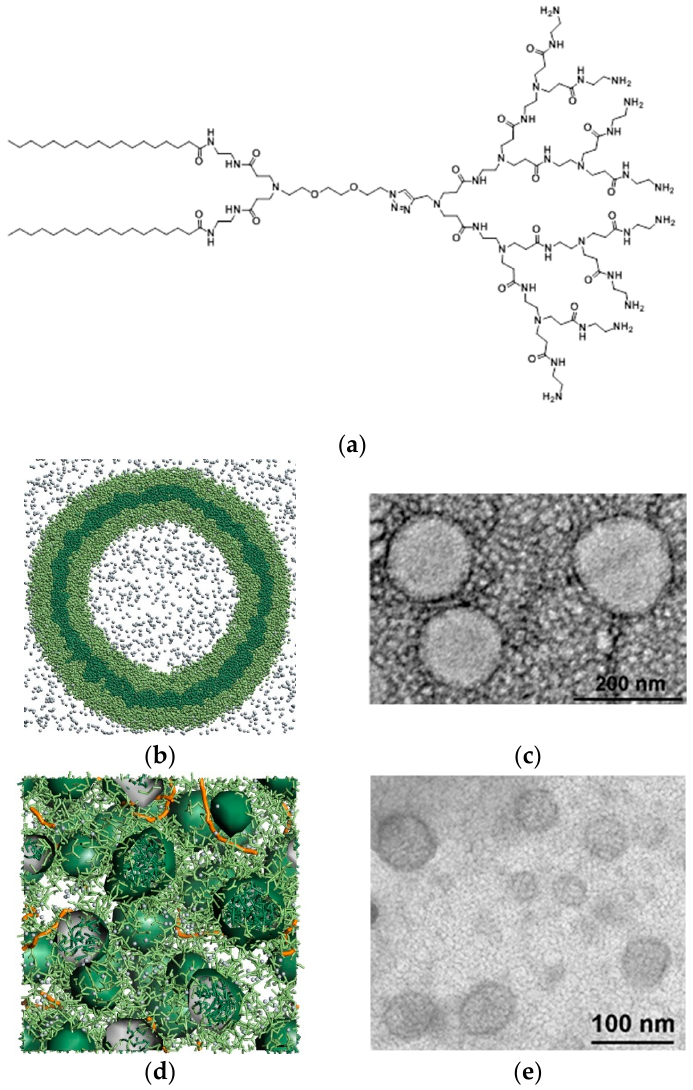
Figure 9. ( a ) The structure of the double-tail amphiphilic dendron simulated ( b ) and experimental TEM images ( c ) of the vesicle-like dendrimersomes formed by AD alone upon self-assembling in buffer solution. In panel b, the hydrophilic units of AD are portrayed in light green, the hydrophobic units are depicted in dark green, while light grey spheres are used to show some representative water molecules. Simulated ( d ) and experimental TEM images ( e ) of the nanosized spherical micelles formed by AD in the presence of siRNA molecules in solution. In panel ( d ), colors as in panel ( b ), while the nucleic acid fragments are portrayed as orange sticks. Adapted from [6] with permission of John Wiley and Sons, 2014.